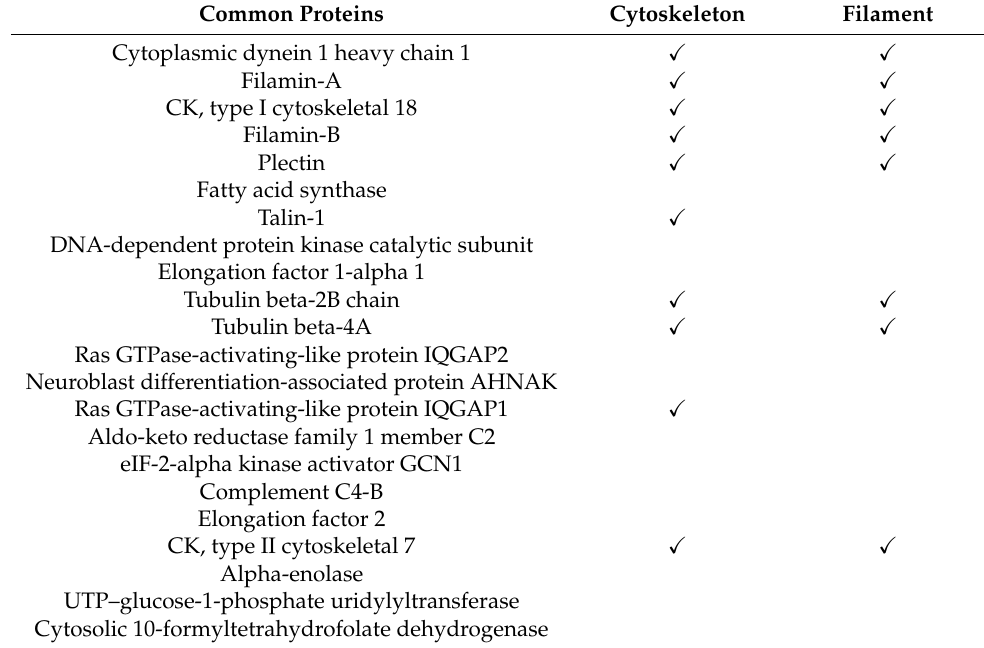
Table 3. Common proteins from analyses presented in Tables 1 and 2. Tick marks ( (cid:88) ) denote whether the protein is related to the cytoskeleton or is a related to or is a structural filament protein. Common